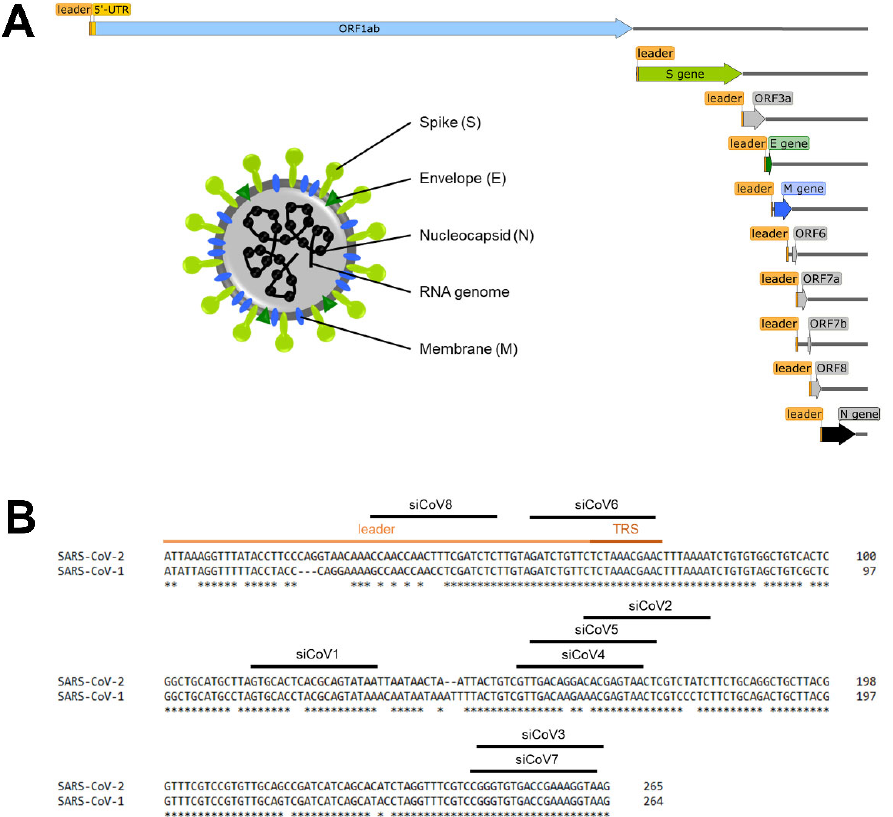
Figure 1. Schematic overview of the SARS-CoV-2 genome and target sequences of the siRNAs in the 5 (cid:48) -UTR. ( A ) Schematic overview of the SARS-CoV-2 genome, the subgenomic RNAs and the virion structure. The coronavirus virion consists of the structural spike protein (S), envelope protein (E), membrane protein (M) and nucleoprotein (N). The single ‐ stranded RNA genome with positive polarity is encapsulated by N, while S ‐ trimers protrude from the host ‐ derived virus envelope and enable binding to new host cells. In addition to the genomic RNA, nine subgenomic RNAs are synthesized during replication, all of which share the same 5’ ‐ and 3’ ‐ ends. The orange box represents the mutual 5’ ‐ end, the leader sequence. ( B ) Target sequences of the siRNAs in the 5’ ‐ UTR of SARS ‐ CoV ‐ 2. The leader sequence (light orange) and the transcription regulatory sequence (TRS, dark orange) can be found at the 5’ ‐ end of the genomic and subgenomic RNAs. Nucleotides without an asterisk differ from the SARS ‐ CoV ‐ 1 5’ ‐ UTR sequence.